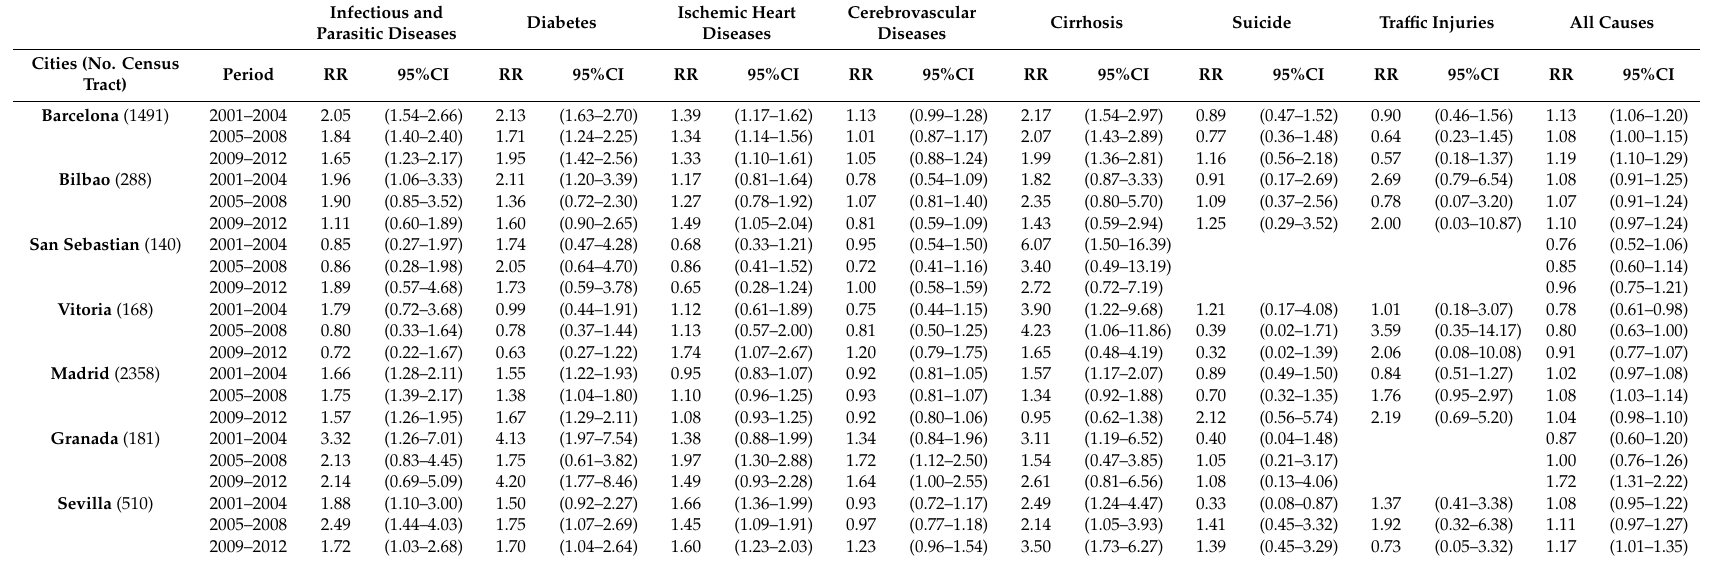
Table 4. Association between mortality and the deprivation index. Relative risk comparing the 95th to 5th percentiles of the deprivation index by period and cause of death in 7 Spanish cities for women,